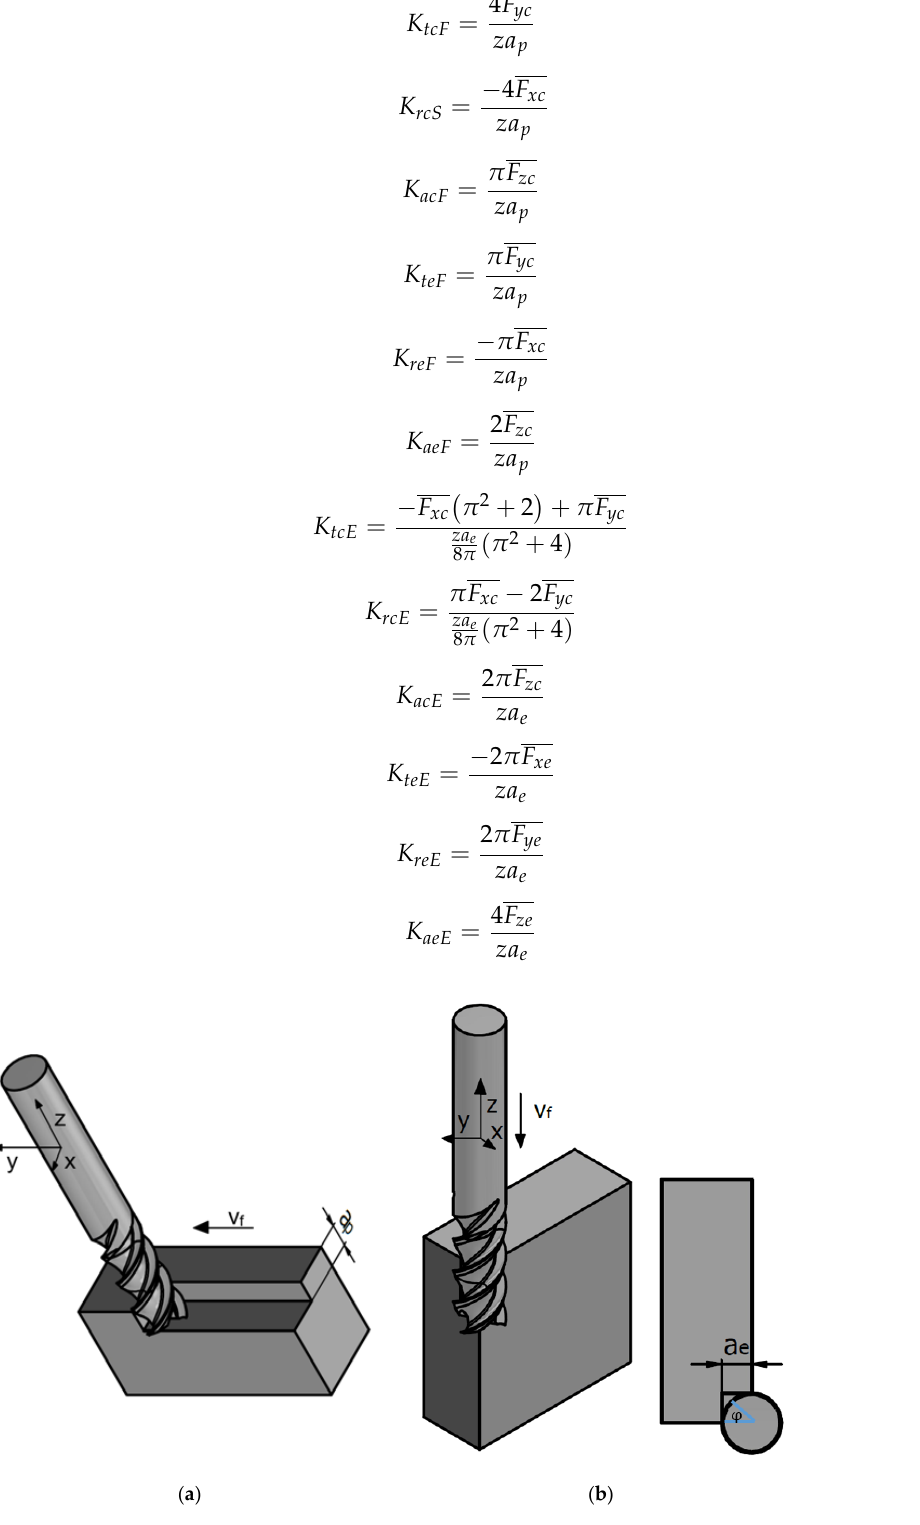
Figure 6. Kinematics of ( a ) slot and ( b ) plunge milling.